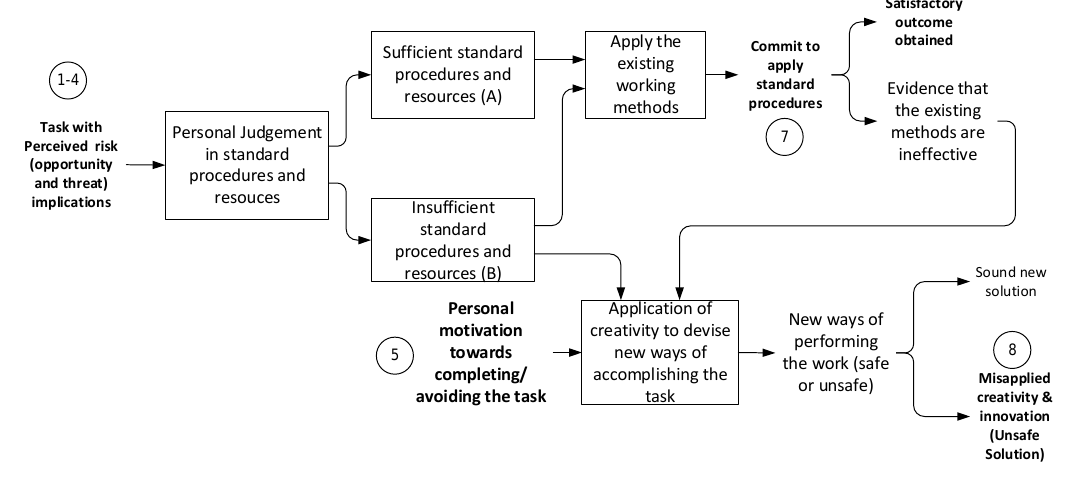
Figure 7. Workers Determine Approach.